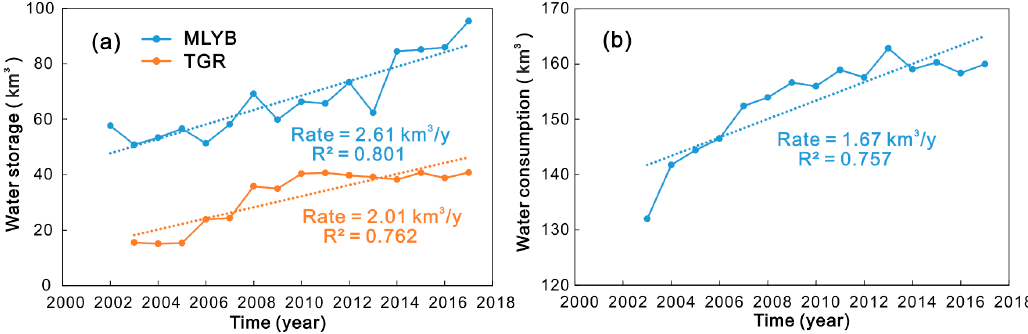
Figure 11. ( a ) The year-end water storage of large and medium reservoirs in the MLYB and the Three Gorges Reservoir (TGR) during 2002–2017 and ( b ) annual human water consumption in the MLYB during 2003–2017, with the change rates and determination coefficients (R 2 ).